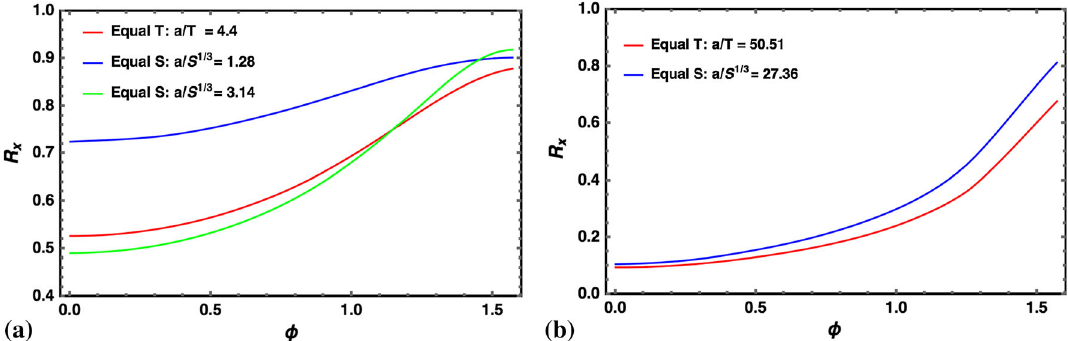
Fig. 3 a The ratio of stopping distance of the quark in the anisotropic medium to the stopping distance in the isotropic medium R x = x aniso / x iso at mid anisotropy at equal temperature (red) and equal